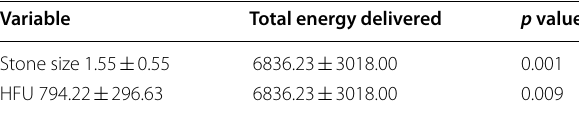
Table 8 Total energy delivered vs. stone size and